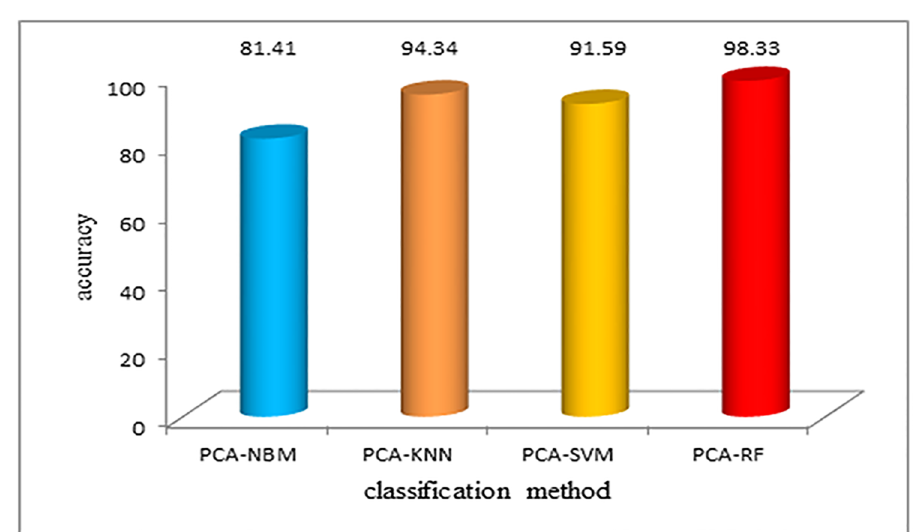
Fig 11. Classification accuracyusing different algorithms after PCA dimension reduction. After using the PCA method to reduce the dimensionof the data, the classification accuracy was improved, and the PCA-RF algorithmstill showedexcellentperformance, as shown in Fig